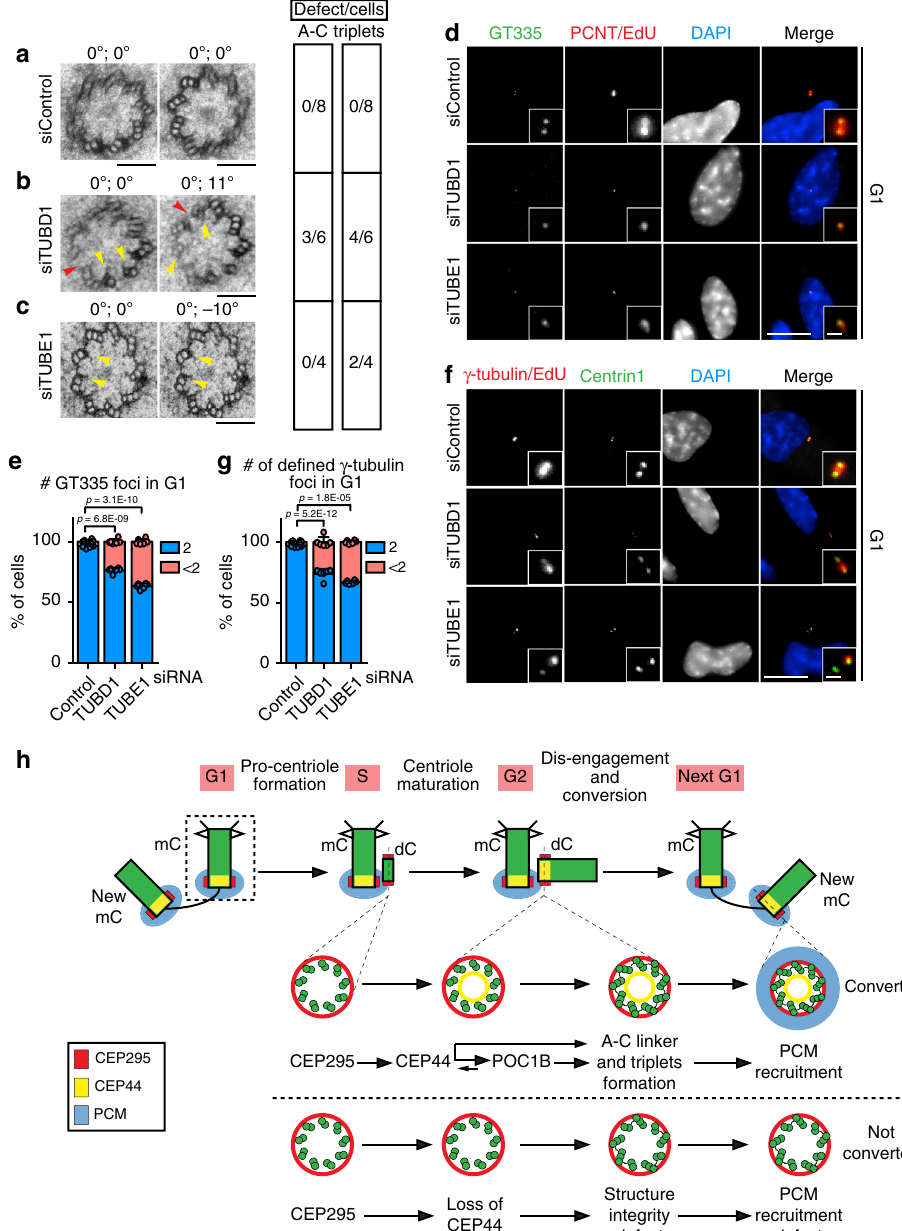
Fig. 7 Structural integrity of the centrioles ensures their conversion to centrosomes. a – c EM images of turned and tilted sections of proximal region of daughter centrosomes in G1. The two values on the top of the image give the turning and tilting degree of the sample, respectively. Red arrowheads indicate open structural defects (A – C linker absent), while yellow ones highlight defects of triplets. The side table (right) shows quanti fi cation of the number of cells showing these defects. While in a G1 siControl cells had no structural defects, in b siTUBD1 and c siTUBE1 G1 dCs showed defects in triplet formation (yellow arrow). b siTUBD1 G1 cell with defect in the A – C linker formation on top of the triplet formation of dCs and lack of triplet MTs (red arrow). d Depletion of TUBD1 and TUBE1 proteins also generated reduced glutamylation of the centrioles as judged by GT335 staining (36.7 ± 2.2% of G1 cells, Cenp-F in Supplementary Fig. 12a) with <2 GT335 foci in siTUBE1 sample; 23.5 ± 2.0% for siTUBD1). e Quanti fi cation of d . f In absence TUBE1 or TUBD1 many centrioles in G1 cells (Cenp-F in Supplementary Fig. 12b) did not ef fi ciently acquire PCM (<2 γ -tubulin de fi ned foci) to convert to centrosomes. g Quanti fi cation of f . 33.1 ± 1.3% of cells with <2 γ -tubulin foci in G1 for siTUBE1; 26.2 ± 4.1% for siTUBD1. ( a – c , scale bars: 100 nm; d , f scale bars: 10 μ m, magni fi cation scale bars: 1 μ m; e , g data are presented as mean ± s.d., all statistics were derived from two-tail unpaired t -test analysis of n = 6 biologically independent experiments and source data are provided as a Source Data fi le). h Model of the dependency of CCC mechanism on the correct centriolar wall maturation. See Discussion for centrioles (Supplementary Fig. 12c). Interestingly, the centriole POC1B (Supplementary Fig. 12f – i). ε - and δ -tubulin therefore wall defects generated by the loss of ε - and δ -tubulin did not function in between CEP295 and CEP44. affect the early CCC component CEP295 (Supplementary We conclude that a correctly assembled centriole is likely to be Fig. 12d, e) but it did delocalise CEP44 and its binding partner a prerequisite for the ability to recruit PCM to the new dC.